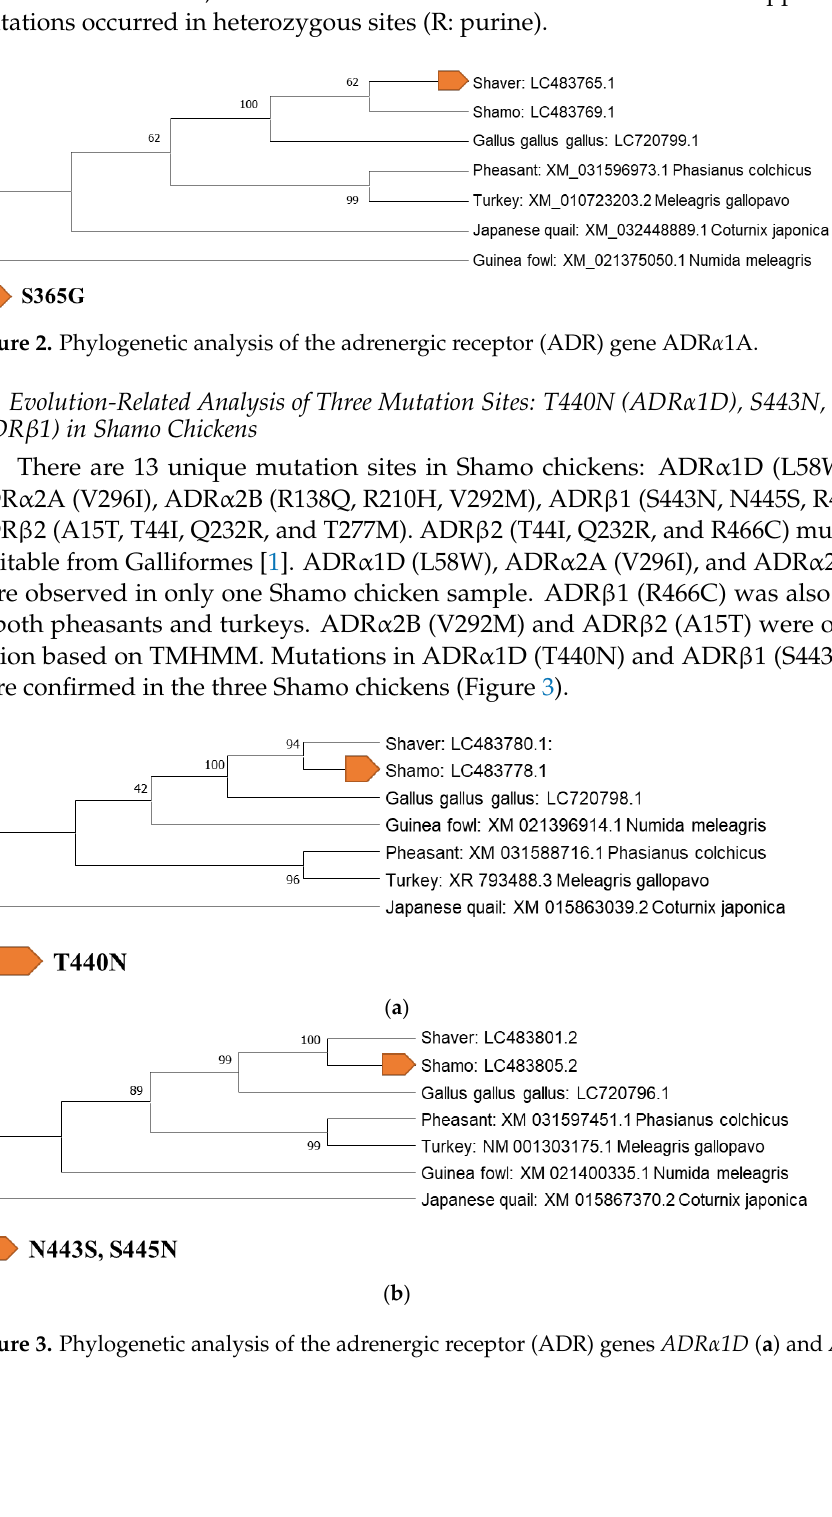
ADRα2A ( V58I, D273E ), ADRβ1 ( R403Q ), and ADRβ3 ( R342C, S396P, Q404L, P406S) were common mutations specific to the two breeds. Only S396P of ADRβ3 was also found in pheasants and Japanese quails. ADRα2A (V58I) was confirmed in pheasant s and ADRβ1 (R403Q) in guinea fowl. Therefore, these three mutations were identified in two of the domesticated chickens, suggesting that they were strongly influenced by artificial selection (Figure 4).